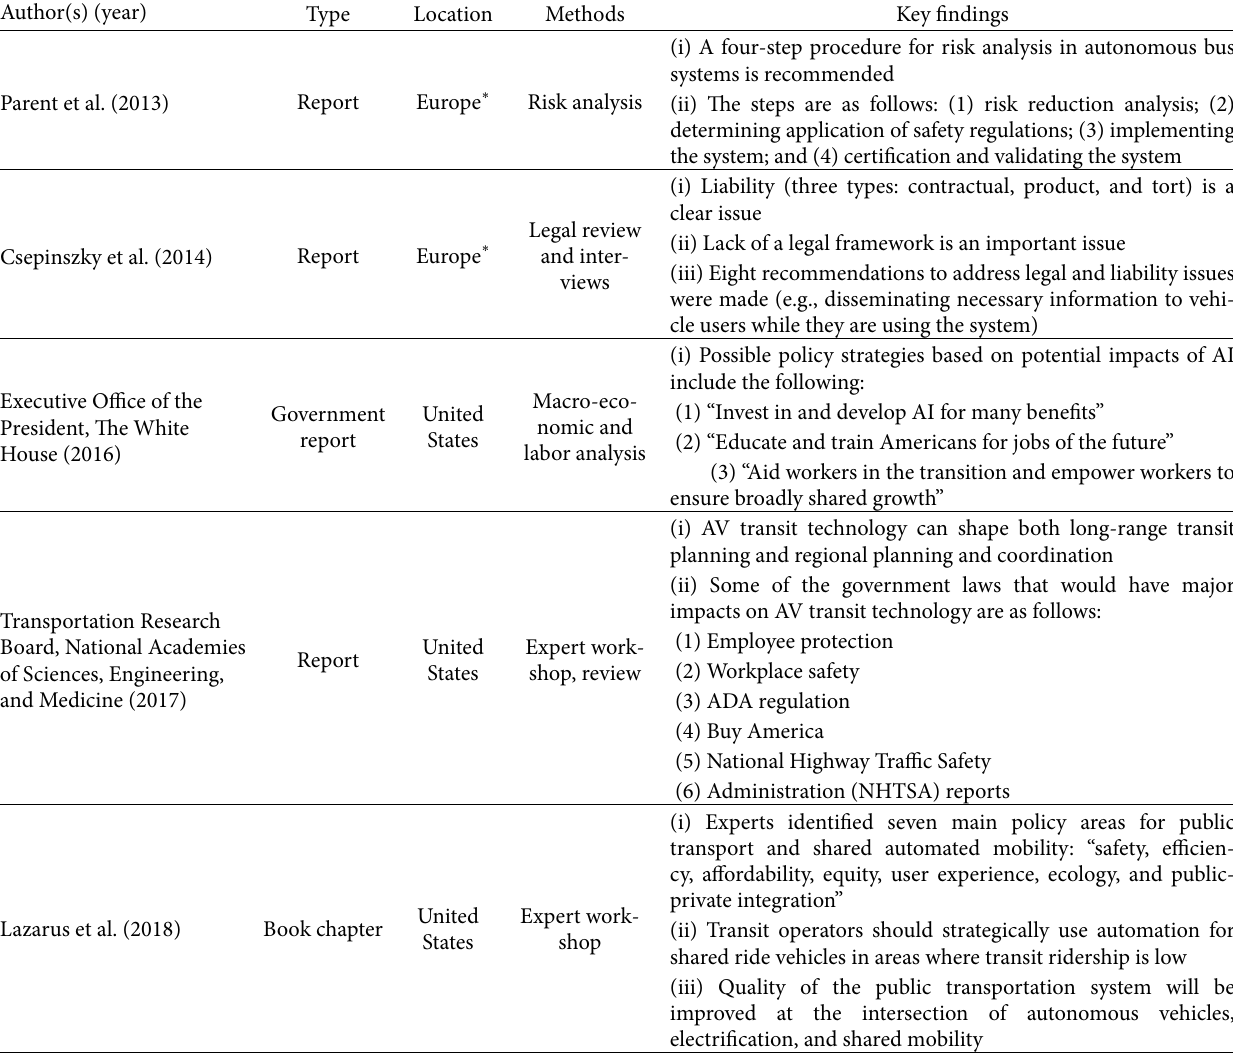
Table 5: Key studies on regulation, policies, and legal issues of autonomous